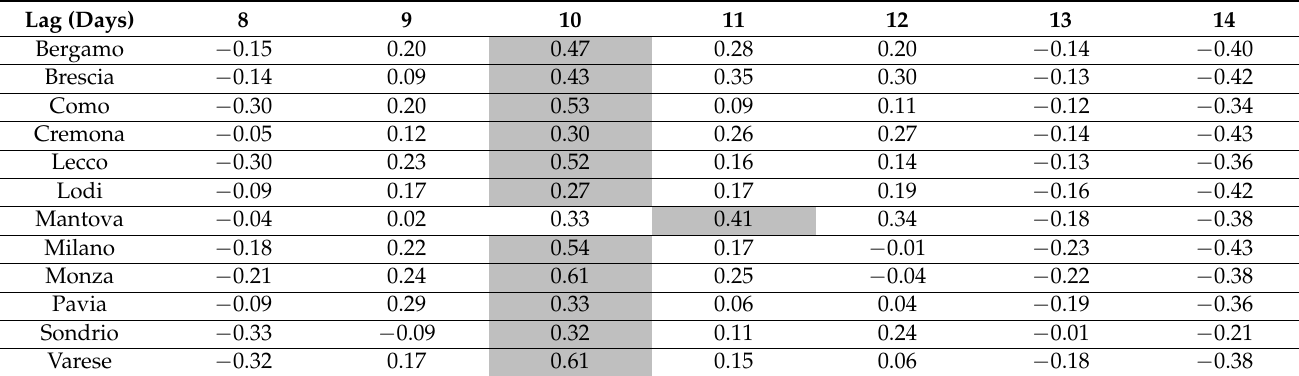
Table 3. Cross-correlation values between the daily incidence of infection and the PM10 concentration obtained varying the lag between the two series.